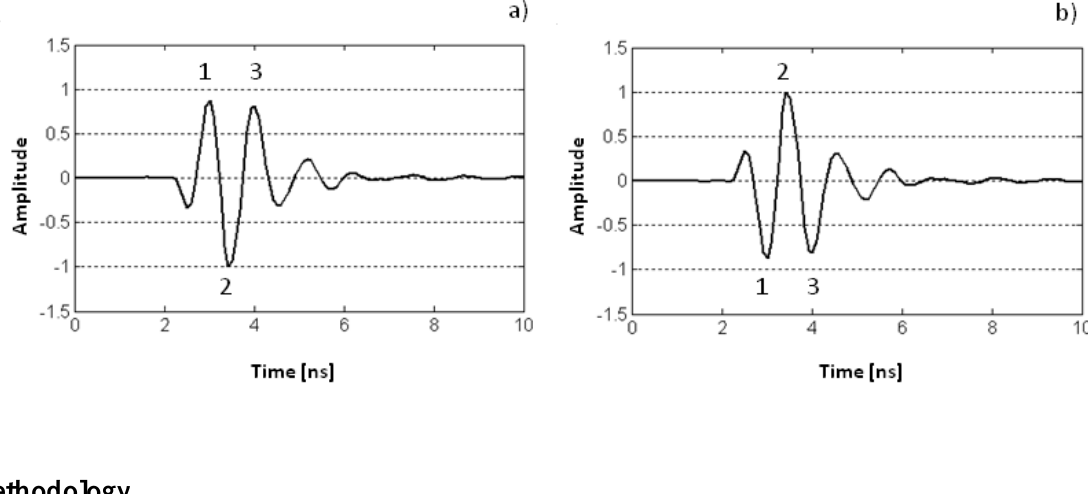
Figure 3. Signals (a) and (b) represent the same wavelet but with different